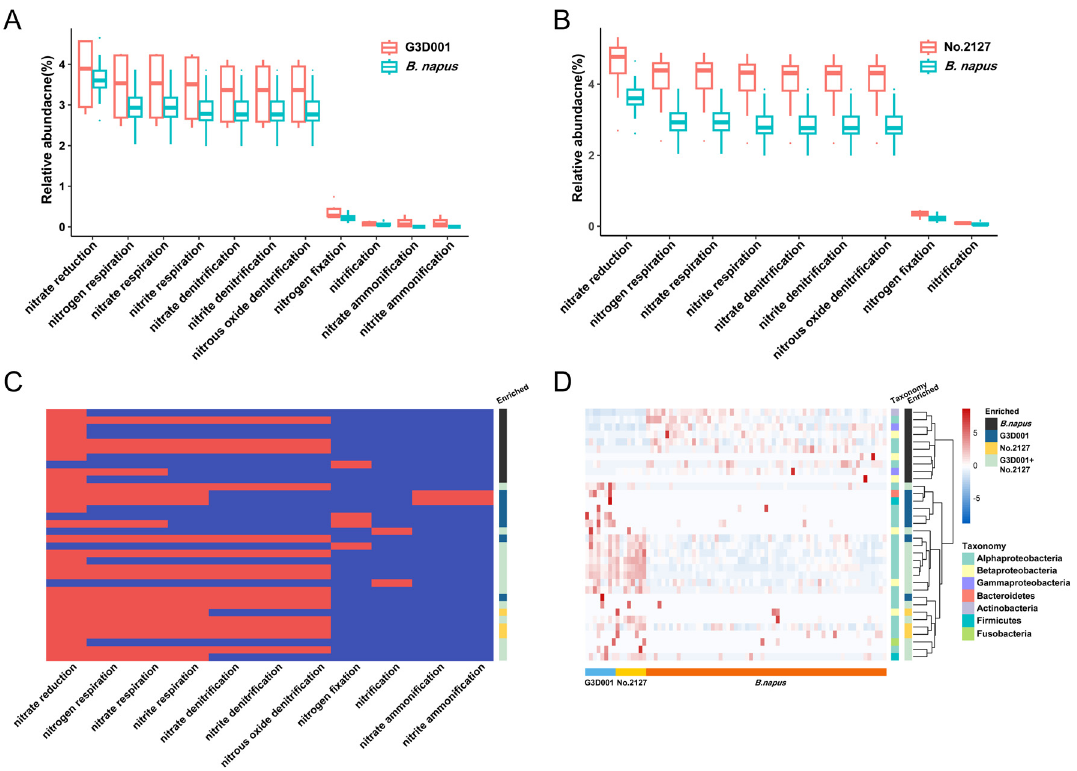
Figure 5. Difference and taxonomy of nitrogen metabolism-related OTUs in the rhizosphere microbiota of B. napus and synthetic B. napus G3D001 and No.2127. ( A , B ) Differences in nitrogen metabolism function of synthetic B. napus G3D001 ( A ), No.2127 ( B ) and B. napus rhizosphere microbiota, respectively. ( C ) Nitrogen metabolism functions of OTUs enriched in B. napus and synthetic B. napus based on FAPROTAX. Each row represents an OTU. The presence of functions is shown in red. ( D ) The heat map shows the relative abundance and taxonomy of OTUs enriched in B. napus or synthetic B. napus G3D001 and No.2127. The presence of functions is shown in red, and the absence of functions is shown in blue.